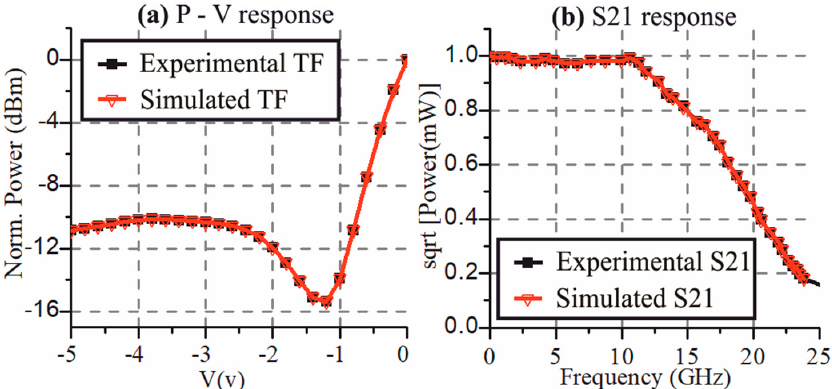
Figure 2. Matching of the experimentally-measured and simulated ( a ) power versus volts transfer functions of the externally modulated laser (EML), and ( b ) S21 response of the EML.